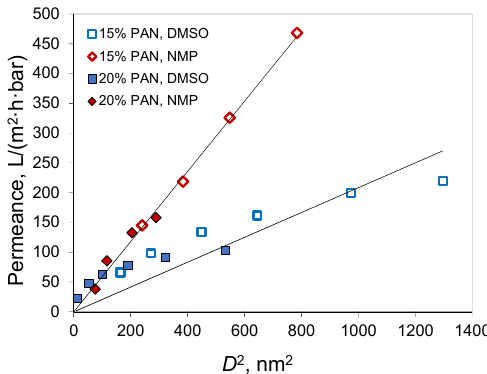
Figure 13. The plot of membrane permeance versus pore diameter ( D ) squared.